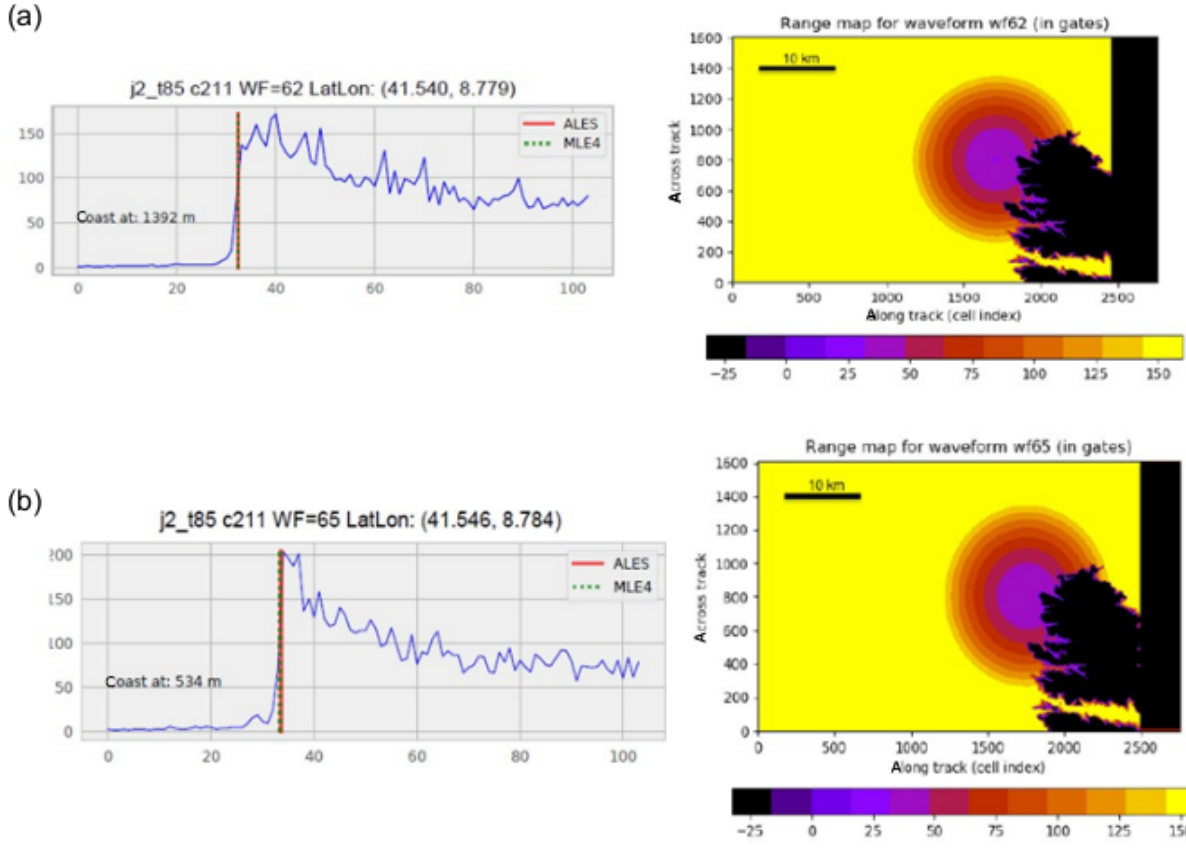
Figure 10. (a) Radar waveform against gate number (left) and configuration of the radar footprint on the ground (right) at 1.4km from the coast. (b) Same as (a) but at 0.5km from the coast.